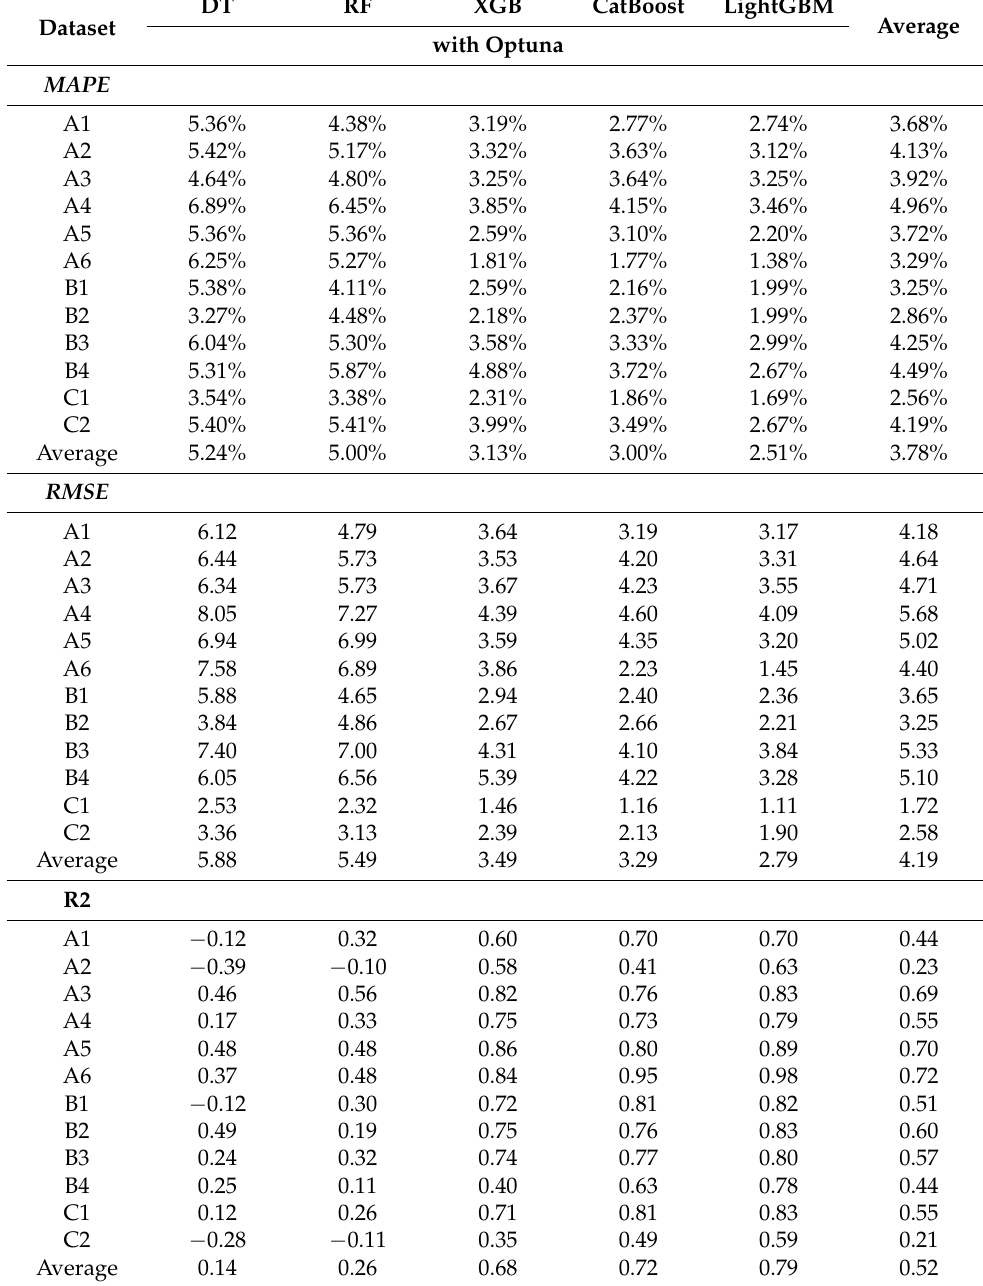
Table 11. The RMSE and R2 results of the tree-based ML model